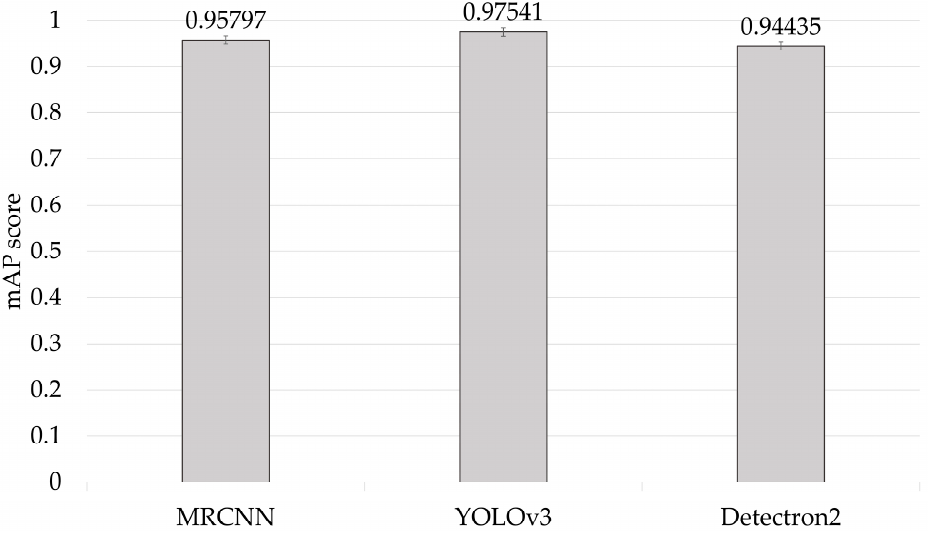
Figure 9. mAP (means of average precision) score for model benchmarking. The performance of the